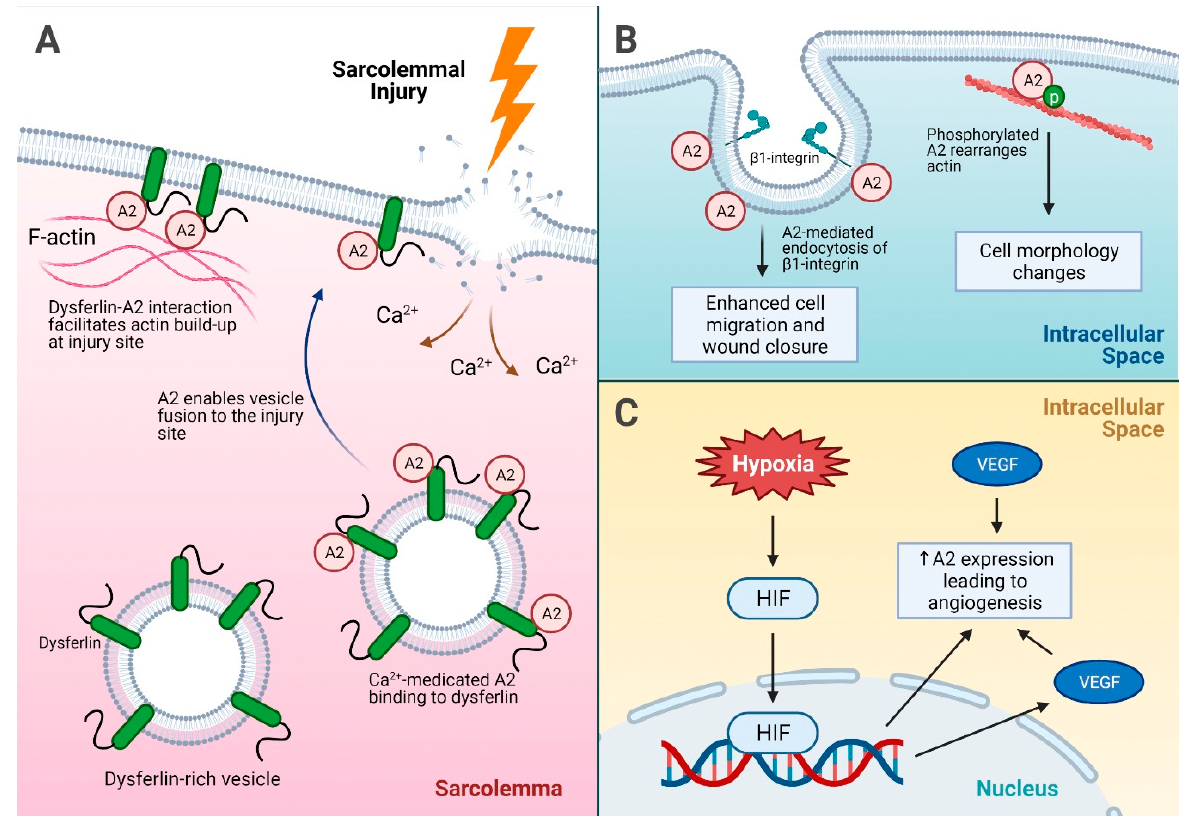
Figure 3. A summary of injury repair mechanisms driven by A2. ( A ) Sarcolemmal injury and the role of A2 in injury site repair. Dysferlin interacts with the A2 intracellular membrane and facilitates actin build up at the injury site. In addition, calcium influx into the sarcolemma after an injury causes A2 binding to dysferlin on dysferlin-rich vesicles, which subsequently fuse to the injury site for membrane repair. ( B ) The mechanisms of cell migration for injury repair facilitated by A2. A2 enhances endocytosis of β 1-integrin, which promotes cell detachment and migration for wound closure. In addition, phosphorylated A2 helps rearrange actin, leading to cell morphology changes and modulation of cellular attachment. ( C ) A2-mediated angiogenesis under hypoxic stress. Hypoxia leads to increased A2 expression via direct HIF-induced expression, and HIF can induce VEGF expression, which indirectly leads to increased A2 expression as well. Increased VEGF alone can also lead to overexpression of A2, which promotes angiogenesis. A2 = annexin A2, HIF = hypoxia inducible factor, p = phosphorylation, VEGF = vascular endothelial growth factor.